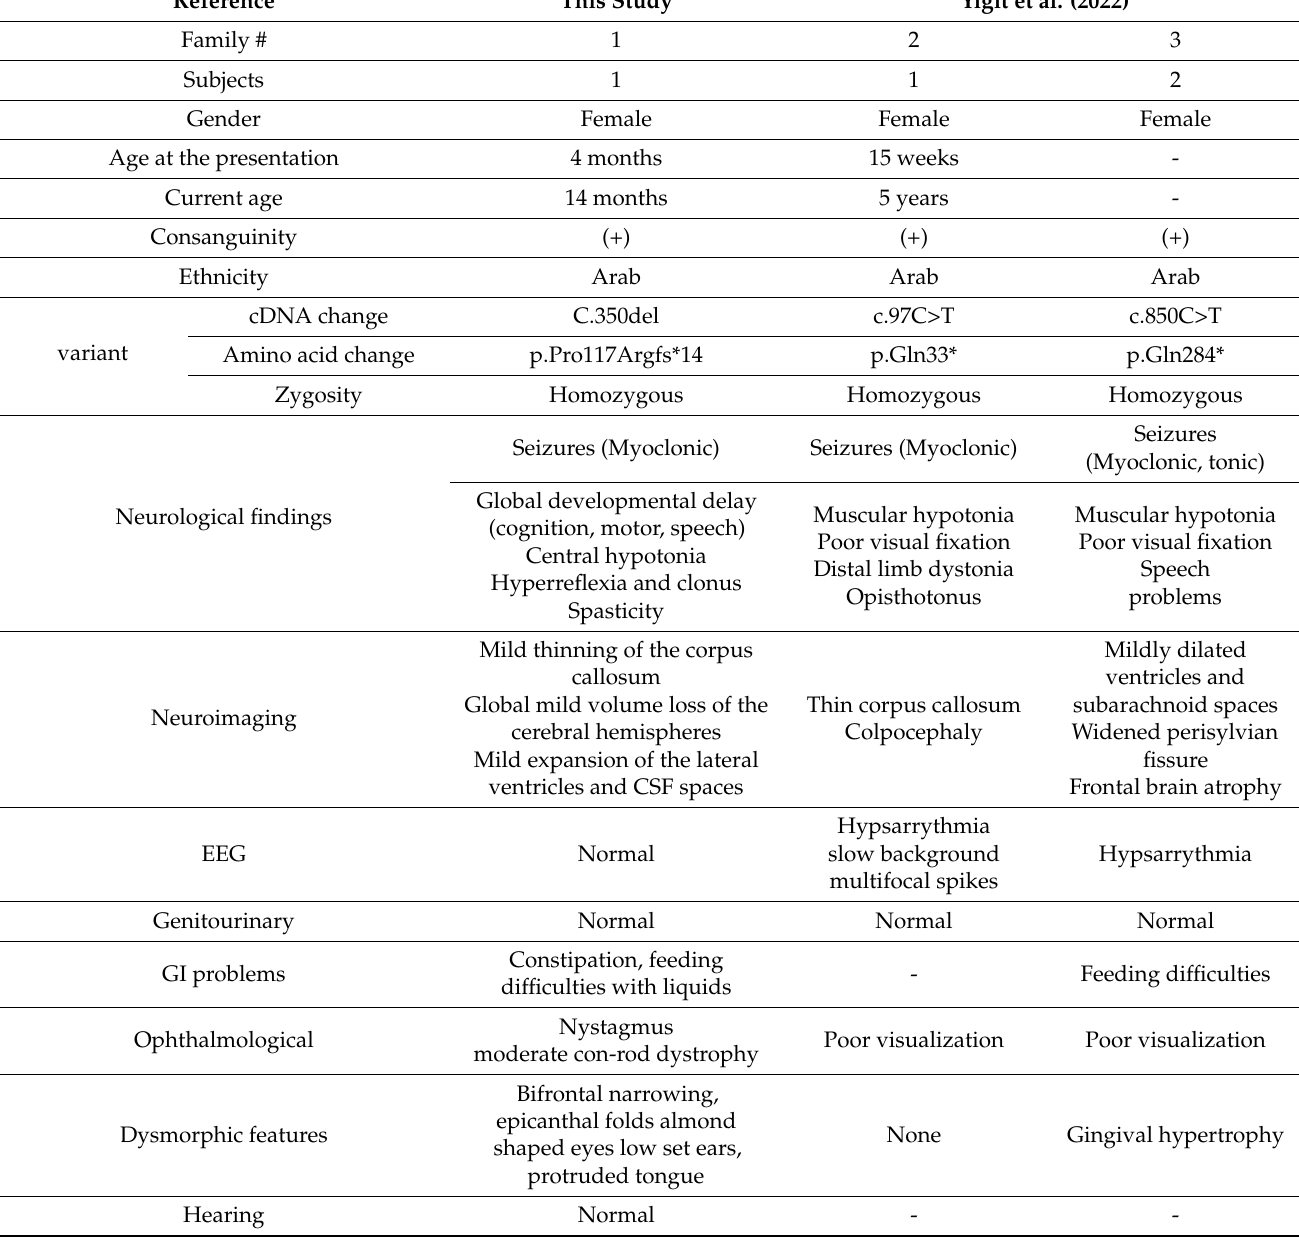
Table 1. Clinical features of patients with a homoallelic loss-of-function variant in DNM1